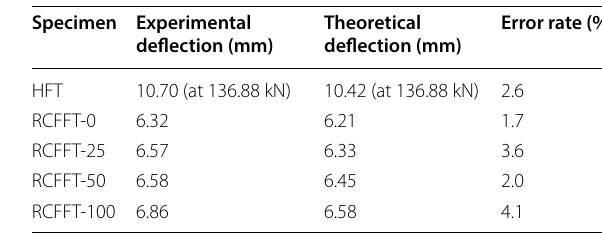
Table 2 Compared